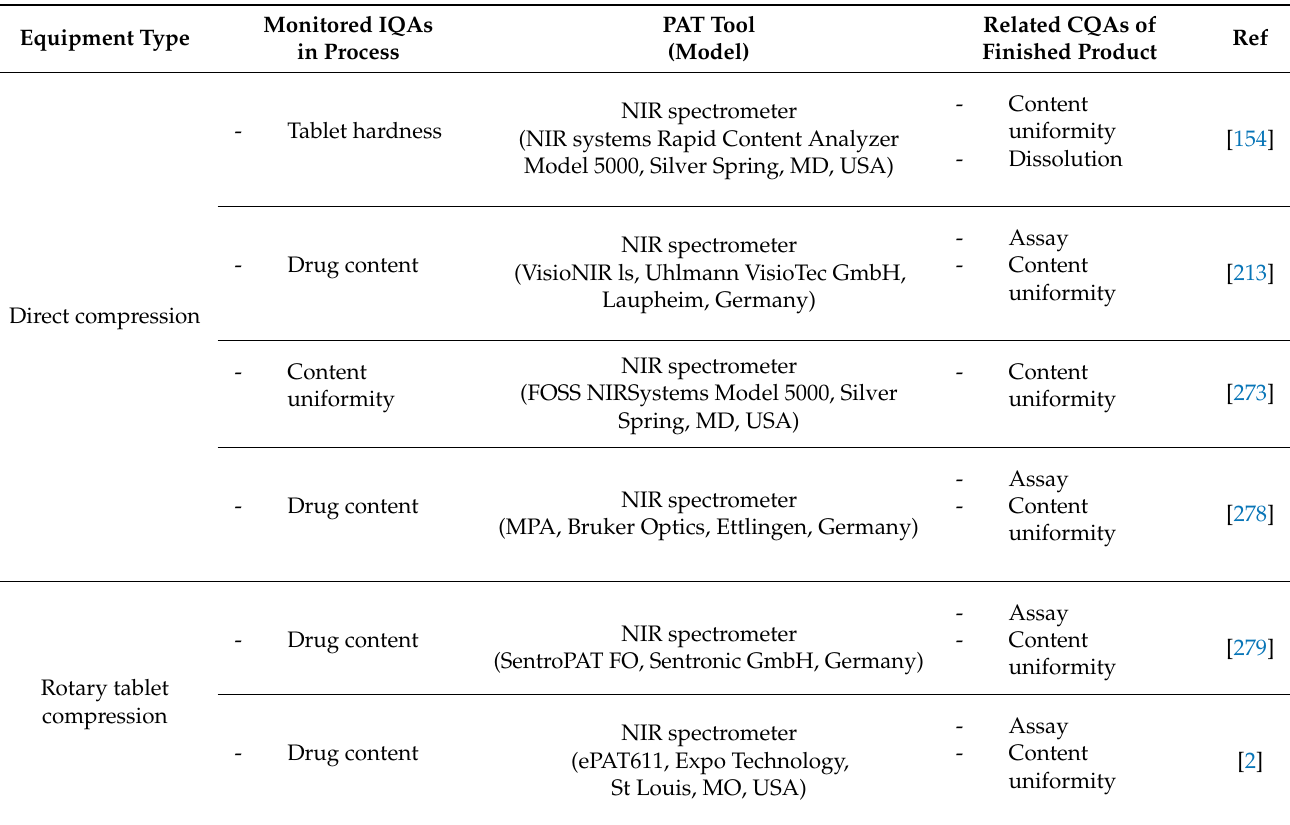
Figure 5. Schematic of the position of three process analytical technology (PAT) tools on the tablet-press feed-frame for monitoring experimental samples [277]. Reproduced with permission from Pedro Dur ã o, Talanta; published by Elsevier, 2017. Table 6. Summary of PAT-based modeling method applied in tableting